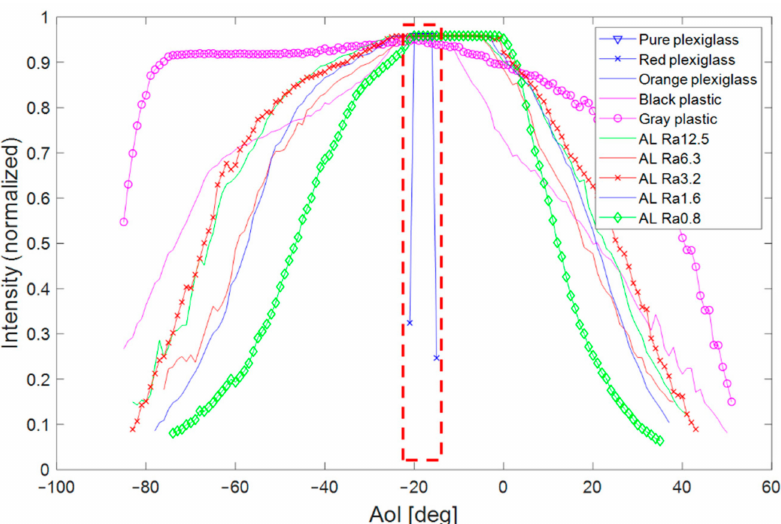
Figure 17. Dependence of the laser intensity on the angle of incidence for all samples; the specular reflection area was marked by a red rectangle with a dashed line.